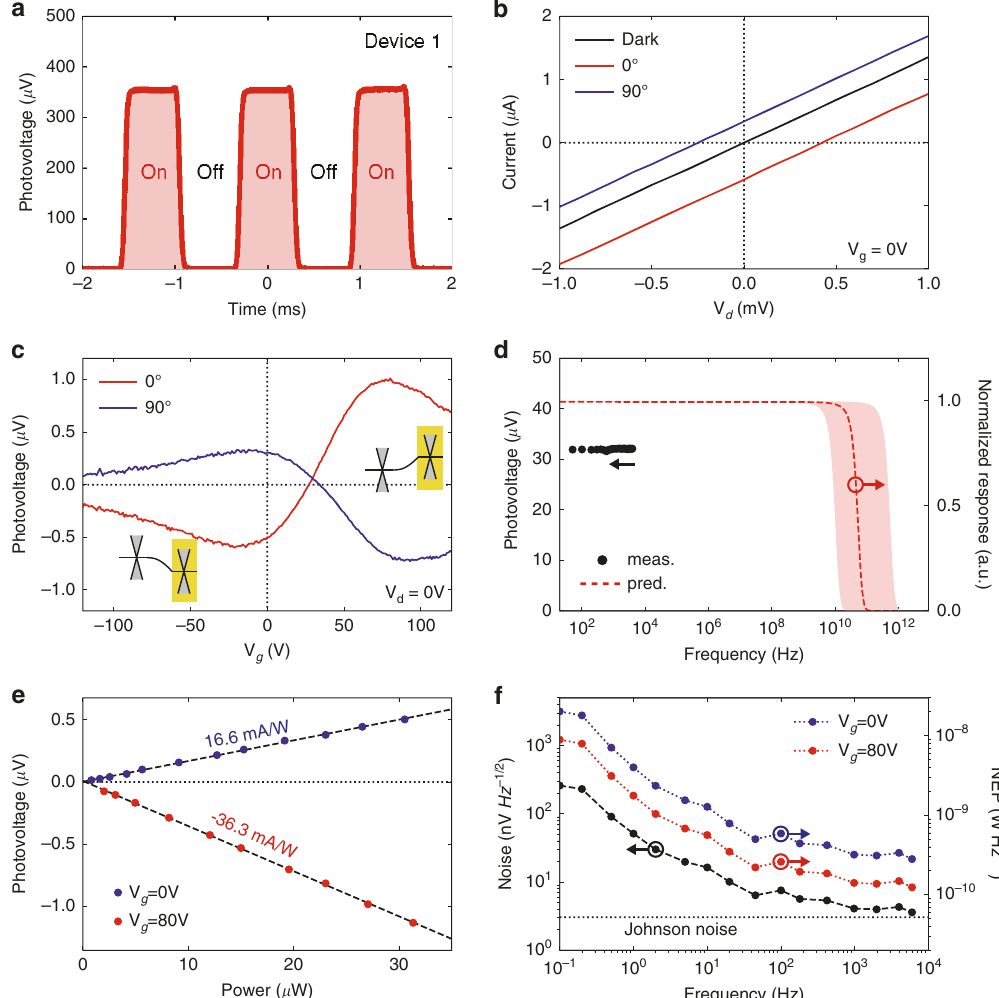
Fig. 3 Device characterization. a Measured photovoltage during on-off cycles of an incident laser at 4 μ m wavelength. Light is modulated with an optical chopper at 800 Hz. b Measured currents versus applied V d at dark and light conditions, with their difference as the photocurrents. 0° and 90° denote the polarization angles of the incident light. The intersections with x and y axes represent open-circuit voltage and short-circuit current, respectively. c Measured photocurrent versus gate voltage at 0° and 90° polarization angles. Inset shows the respective band diagrams. While the Fermi level of the graphene covered by nanoantennas (yellow region) is pinned, the Fermi level of uncovered graphene channel can be tuned by gate voltage, leading to fl ipping of band bending and hence opposite photoresponse. d Measured and predicted frequency response. Red shaded area denotes the range of reported data and hence the uncertainty of our estimation. e Dependence of photocurrents on the power of incident light at two different gate voltages. The polarization angle is 0°. f Measured frequency-dependent noises and calculated noise equivalent power (NEP). The similar trend between noise and NEP is due to the almost constant frequency responsivity. Johnson noise becomes dominant for frequencies above 1